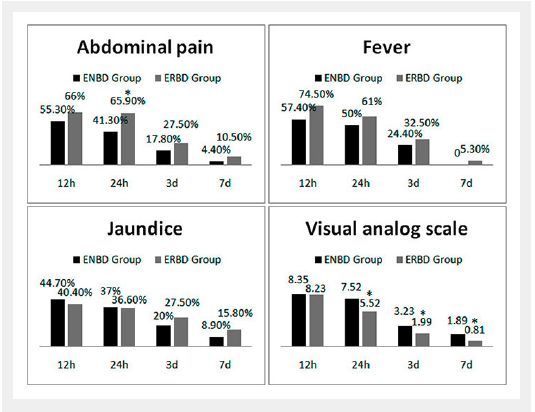
Rates of abdominal pain, fever and jaundice 12 hours, 24 hours, 3 days and 7 days after endoscopic retrograde cholangiopancreatography in the endoscopic nasobiliary drainage (ENBD) and endoscopic retrobiliary drainage (ERBD) groups. * p <0.05 vs ENBD group.